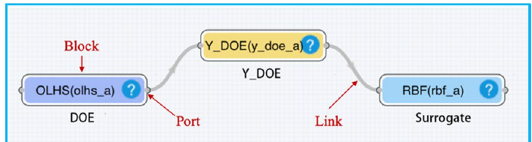
Figure 6 The algorithm blocks and links